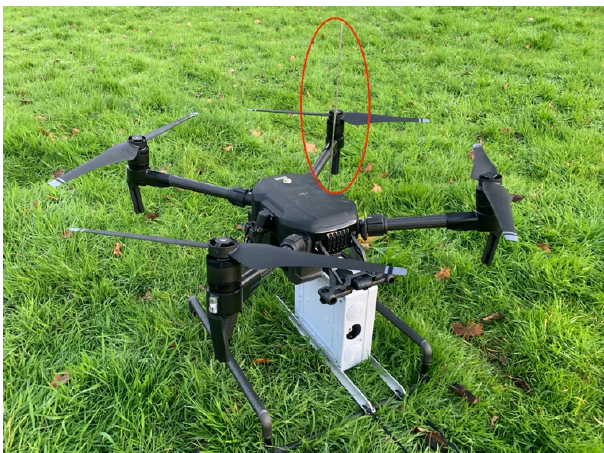
Figure 1. The DJI Matrice 200 V2 with the POPS (white box at the left bottom of the fuselage). The red oval shows the inlet tube leading to the